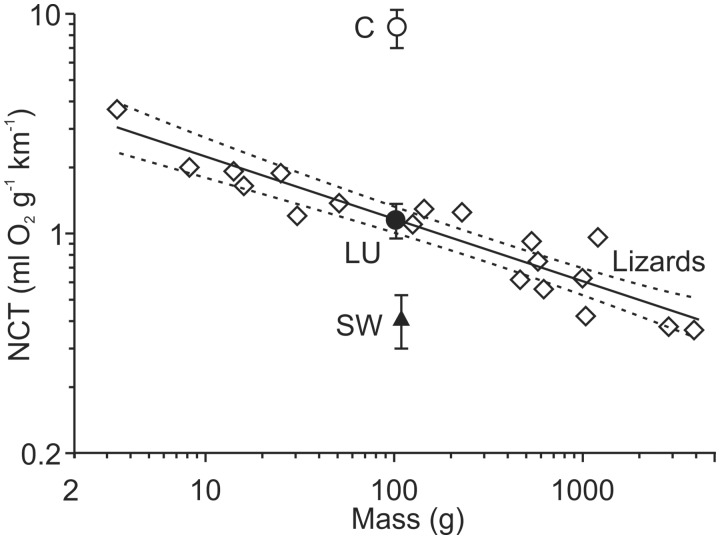
Net cost of transport (NCT) for the terrestrial locomotion of limbed lizards and snakes adapted from (Secor et al. 1992). The values of NCT (±1 SE) for snakes are for a black racer (Walton et al. 1990) performing terrestrial lateral undulation (black circle) and concertina within a horizontal tunnel (white circle) and for sidewinding rattlesnake (triangle) on a treadmill (Secor et al. 1992). Diamonds are values for different species of lizards (John-Alder et al. 1986), for which a collective scaling equation (±95% CL) is shown. Note that the NCT of terrestrial lateral undulation of a snake is statistically indistinguishable from that of a lizard with similar mass, and NCT differs radically among different modes of snake locomotion.